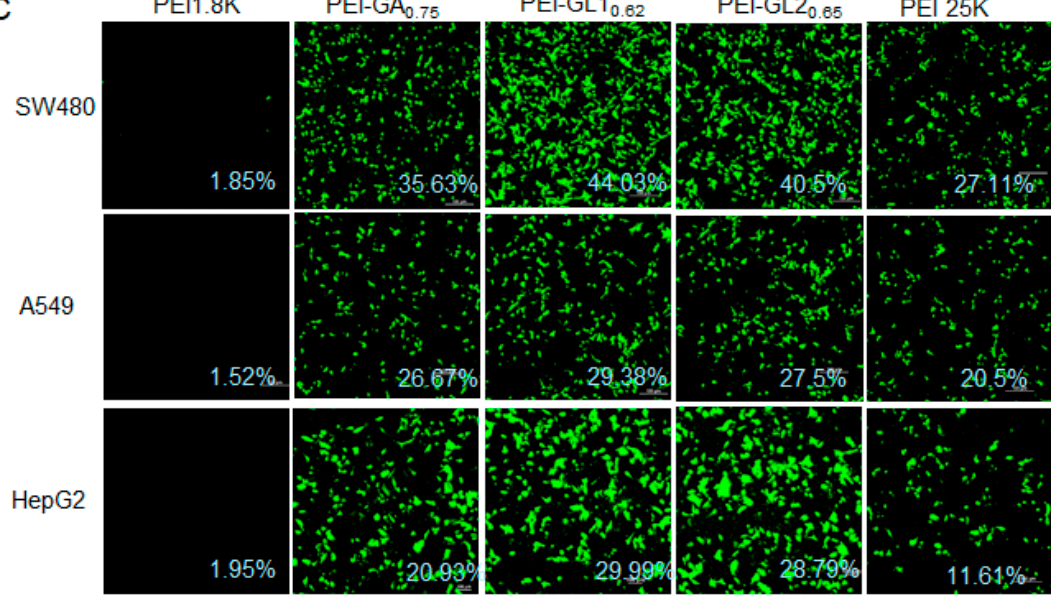
Figure 5. In vitro gene transfection e ffi ciency. Luciferase expression e ffi ciency of PEI-GA / pLUCI and PEI-GL / pLUCI polyplexes and the controls (PEI.8K and PEI25K) in serum-free medium on HepG2 ( A ) and SW480 ( B ) cancer cells with 2.25 µ g / mL Luciferase plasmid concentration. Results are shown as mean ± SD ( n = 3). Statistically significant di ff erences are indicated by * p < 0.05, ** p < 0.01 and *** p < 0.001 using t -test (unpaired). ( C ) Expressing green fluorescence protein (EGFP) expression e ffi ciency of the three polyplexes and the controls on SW480, A549 and HepG2 cells with 2.5 µ g / mL EGFP plasmid concentration observed by confocal laser scanning microscope (CLSM). All scale bars represent 100 µ m and GFP-positive cells are measured by flow